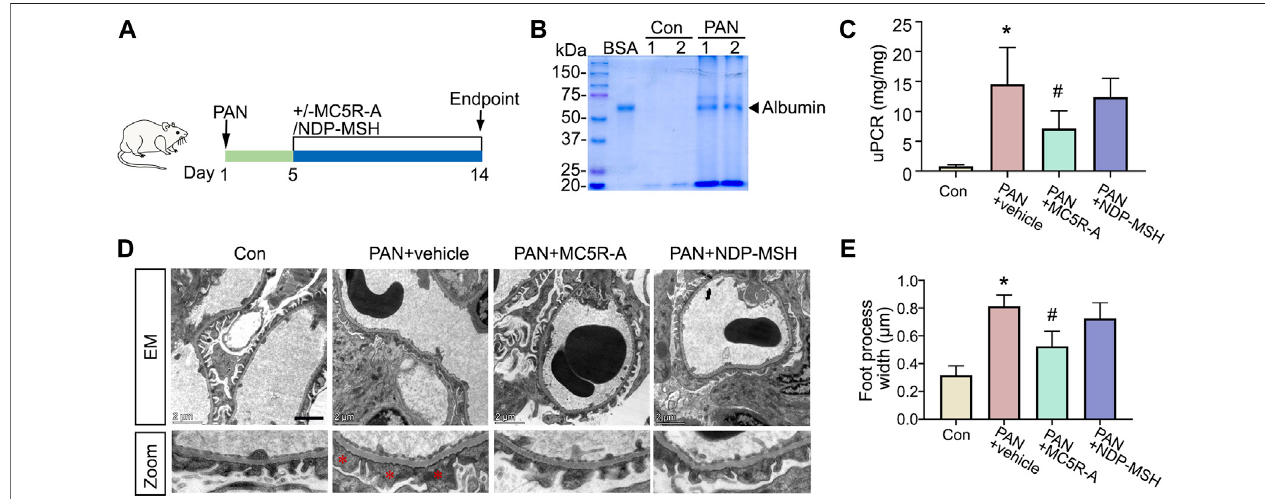
FIGURE 2 | MC5R agonist attenuates proteinuria and podocyte injury in the rat model of PAN nephrosis. (A) Schematic diagram depicts the animal study design. On day 1, rats received a tail-vein injection of PAN or saline as normal controls (Con). Five days after the PAN injection, rats received daily subcutaneous injections of MC5R-A, NDP-MSH or vehicle until day 14, when rats were euthanized. (B) An aliquot of urine collected on day 5 was subjected to SDS-PAGE followed by Coomassie brilliant blue staining. Bovine serum albumin (BSA, 3 μ g) served as a standard control. (C) Urine protein and creatinine levels were assayed, and urinary protein excretion was expressed as urinary protein to creatinine ratio (uPCR). p p < 0.05 versus Con group; # p < 0.05 versus PAN + vehicle group ( n = 6). (D) Representative electronmicroscopicimagesofglomerularultrastructures(Scalebar=2 μ m);Theasterisksindicatefootprocesseffacement. (E) Quanti fi cationofpodocytefootprocess width; p p < 0.05 versus control group; # p < 0.05 versus PAN + vehicle group ( n =